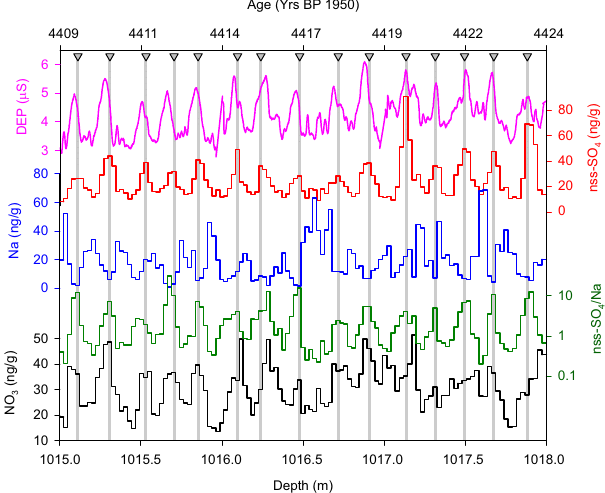
Figure 4. Example of a 3m long ice core section within the WAIS Divide brittle ice zone (approximately 4400 yearsBP), a section for which ice core sample quality was rated poorest (Souney et al., 2014). WD2014 annual-layer markers (triangles with grey lines) are indicated. Annual layers are identified by summer and winter trac- ers: winters are characterized by maxima in [Na + ]; summers are characterized by maxima in [NO − ], [nss-SO 2 − ] and corresponding 3 4 DEP maxima. Also shown is the ratio of [nss-SO 2 − ] / [Na + 4